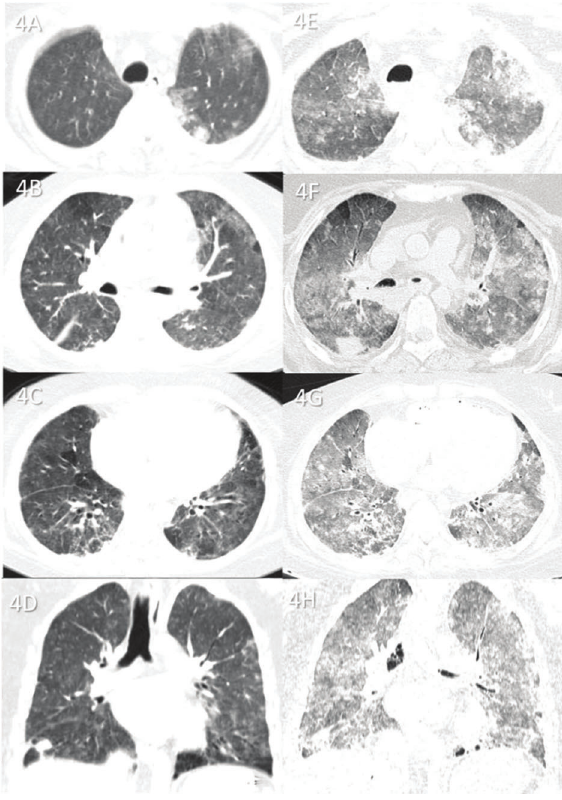
Figure 4 - Case 4: Premortem axial chest computed tomography (CT) of the upper (A), mid (B), and inferior (C) thirds of the lungs obtained 1 day before death showing peripheral ground-glass opacities and diffuse pulmonary mosaic attenuation because of ventilation and/or perfusion disturbances (small hypoattenuat- ing areas in the lungs). Postmortem axial chest CT of the upper (E), mid (F), and inferior (G) thirds of the lungs obtained 18 h 20 min after death showing ground-glass opacities larger than those on premortem CT and associated with small consolidations, indicating progression of the disease before death. Because the postmortem CT is of expired lungs, the pulmonary mosaic attenuation is enhanced. This confirms that the small hypoattenuating lung areas on premortem CT are air- trapping areas on postmortem CT. Images D and H show pre- and postmortem coronal reformats,